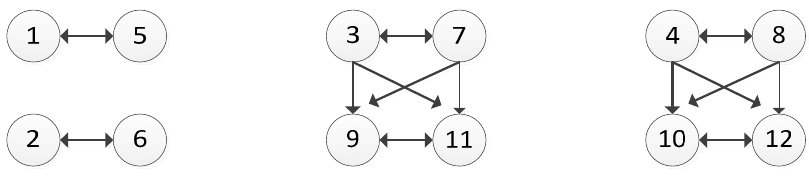
Figure 3. Graph Model of Changzhou Conflict for Movement by BPC. Int. J. Environ. Res. Public Health 2017 , 14 , 1311